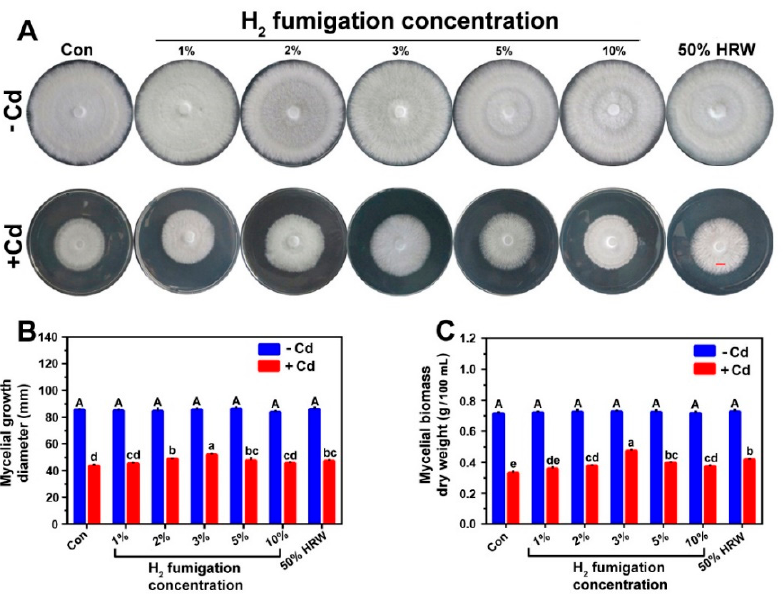
Figure 1. H 2 fumigation increased the mycelial growth diameter and the biomass dry weight of G. lucidum . Mycelial inocula were grown on solid CYM media for 2 days; then, on the 3rd day, were either pre-treated with 1%, 2%, 3%, 5%, or 10% H 2 fumigation or 50% HRW for 24 h or not treated with either hydrogen forms (Con). On the 4th day, 6 mm-diameter mycelial discs from different treatments were cut and grown on solid CYM with or without CdCl 2 for 8 d; then, photographs of the plates were taken ( A ). Scale bar = 1 cm. Diameters of mycelial growth were detected ( B ).